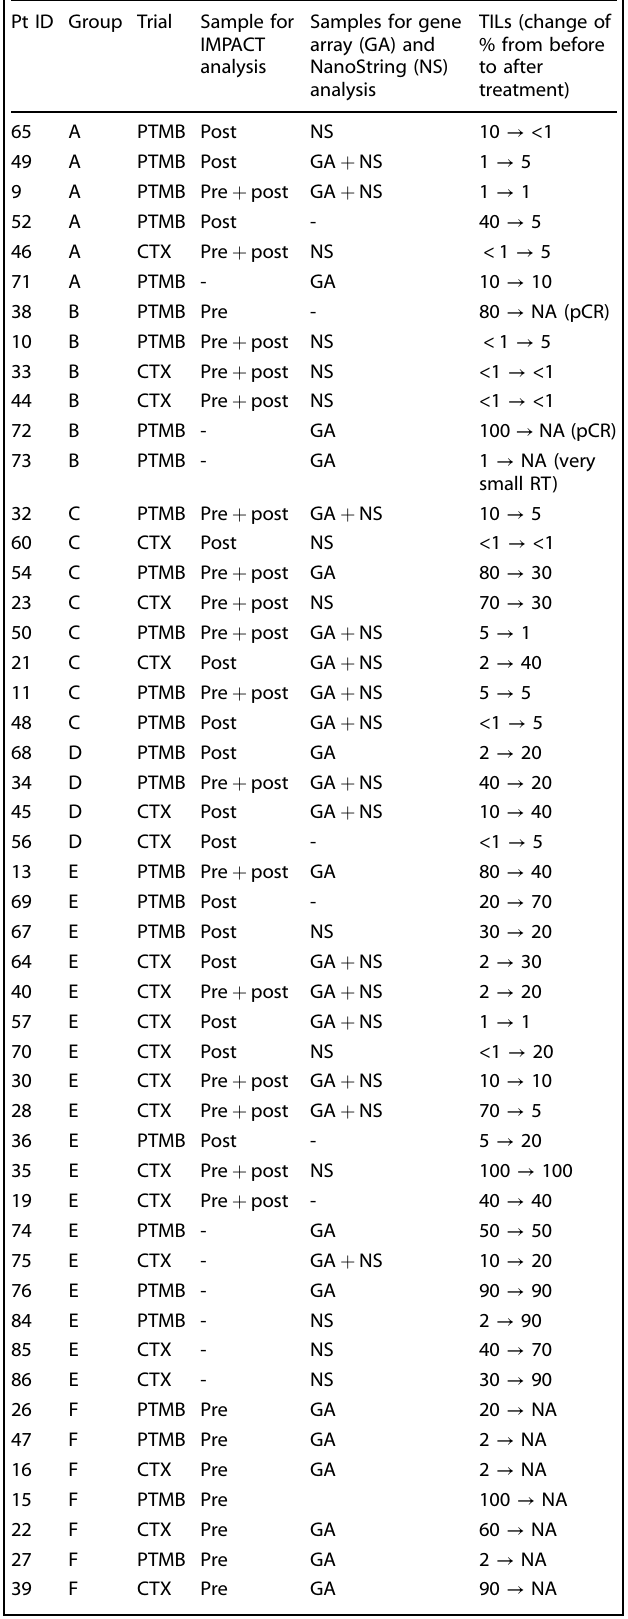
Table 2. Samples used for molecular analyses and results of TIL amount